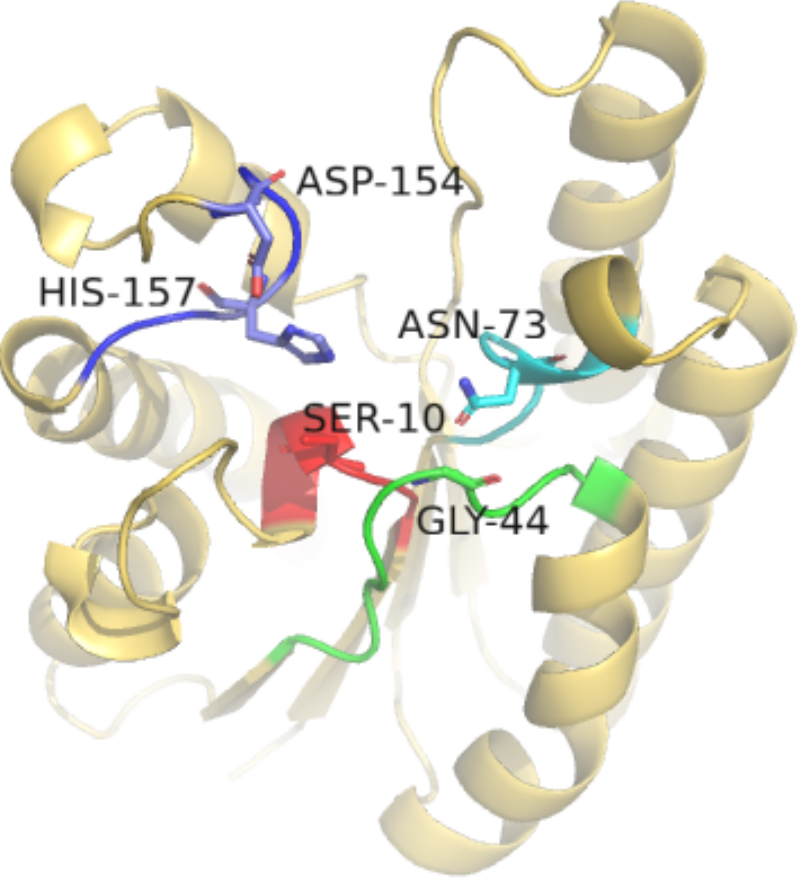
Figure 1. Cartoon representation of E. coli thioesterase